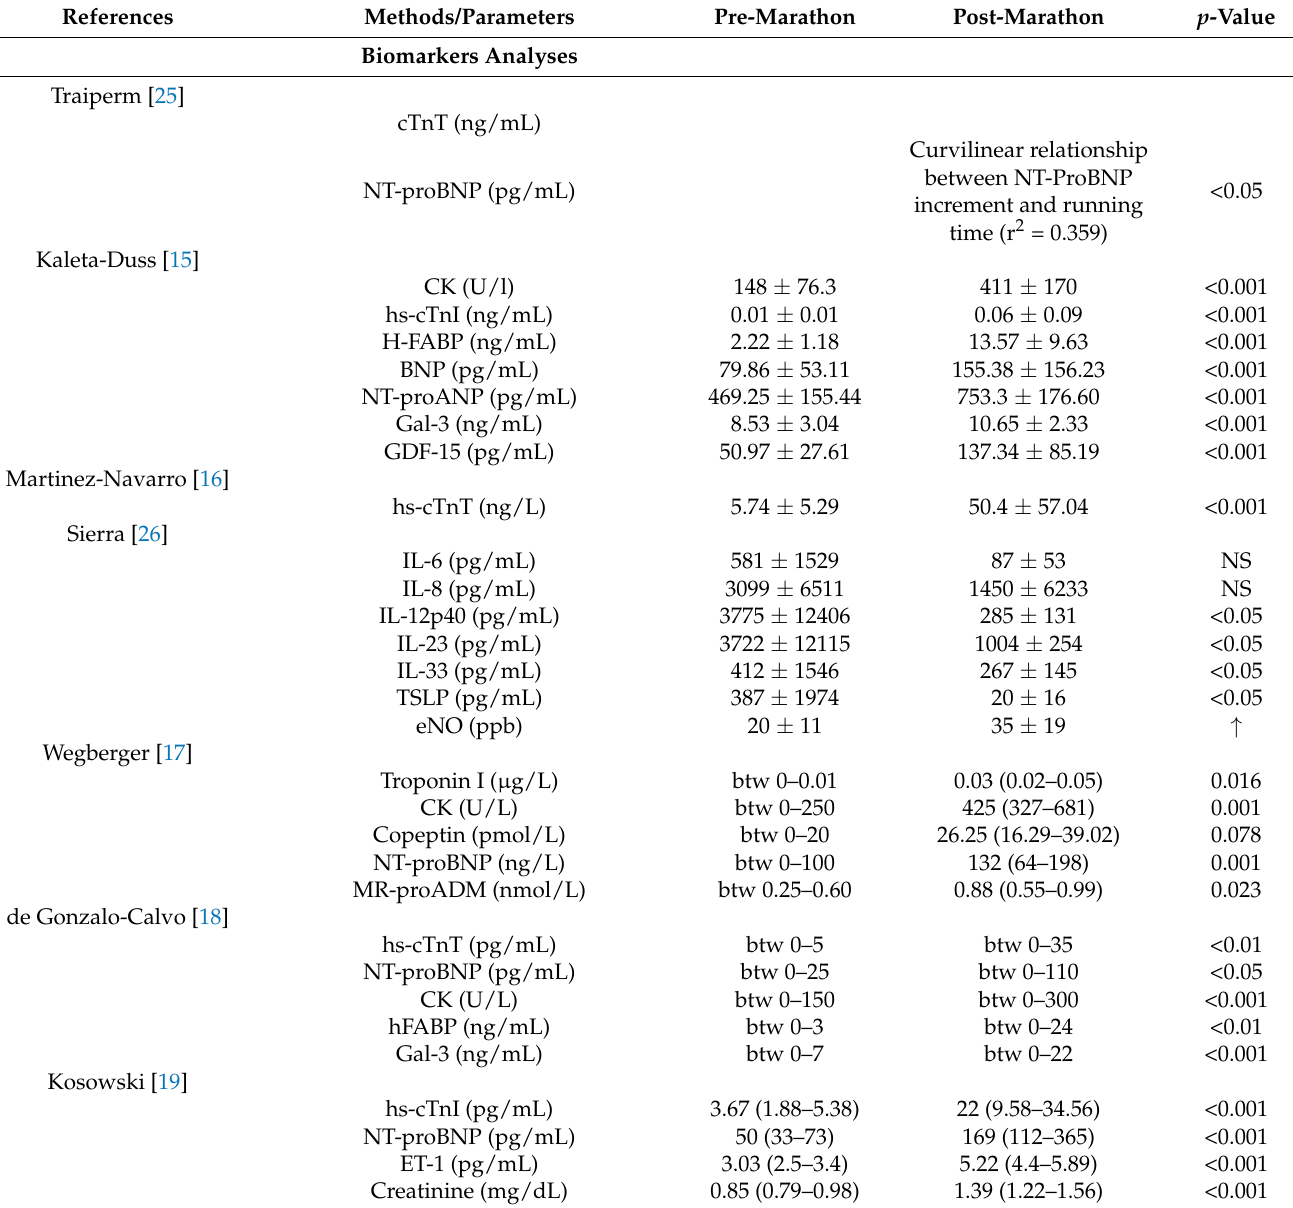
Table 1. Cardiac fatigue, cardiac stress and